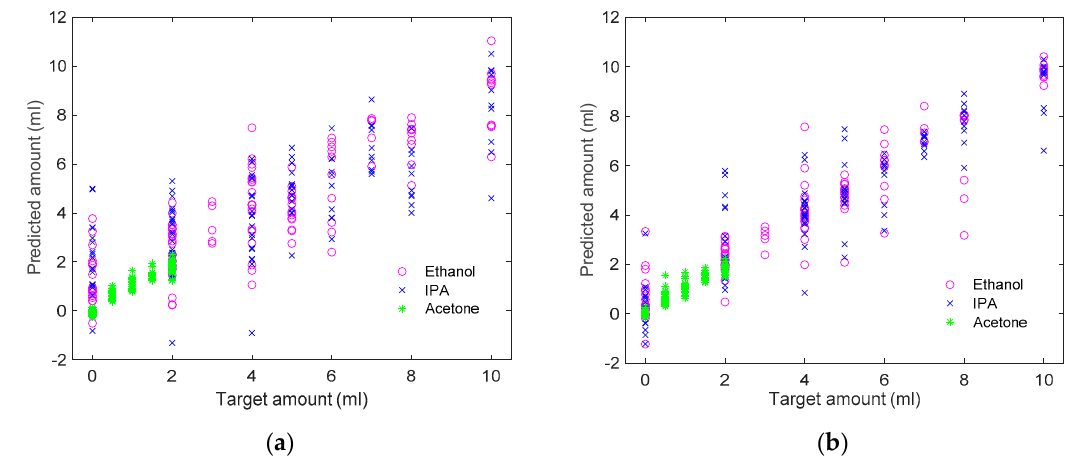
Figure 8. Target versus predicted amount of gas in VOC mixture ( a ) multivariate linear regression ( b ) backpropagation neural network (BPNN).